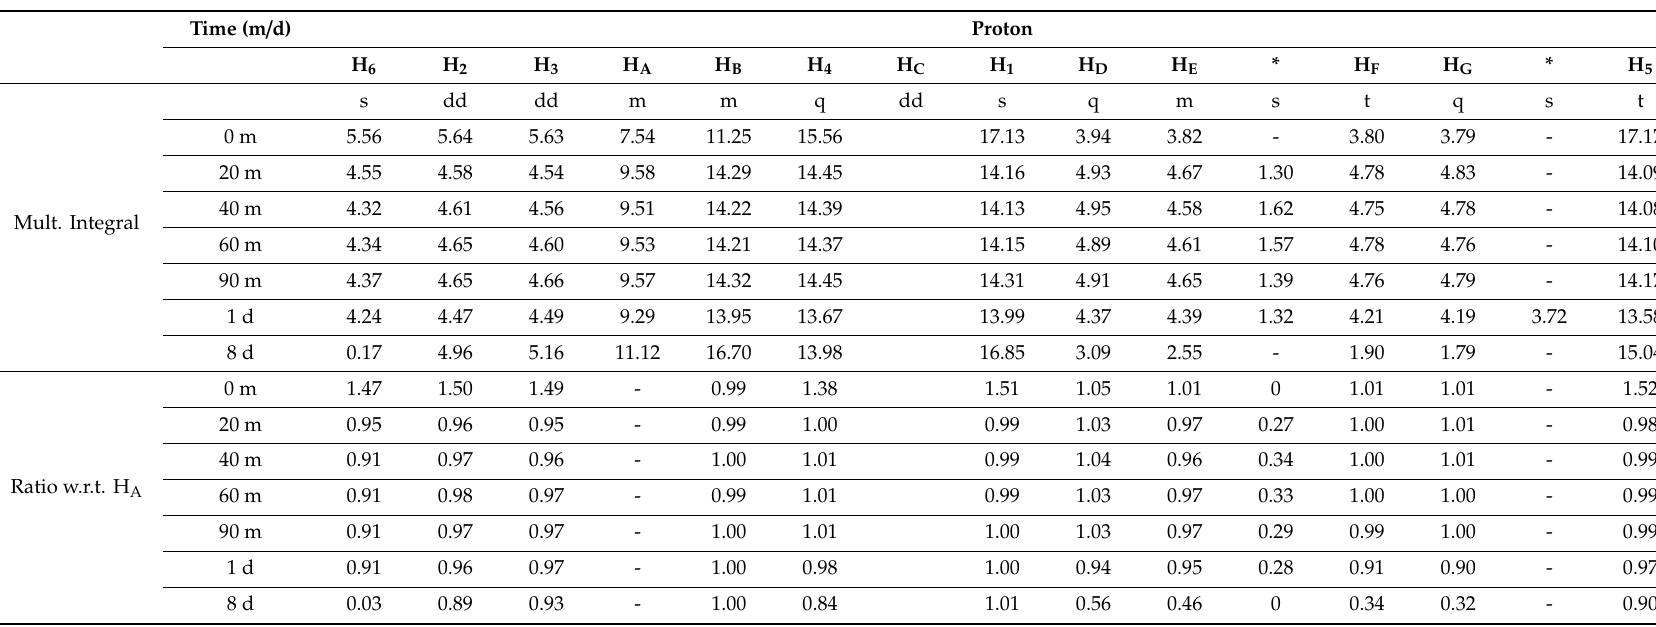
Table 2. 1 H NMR spectral data for equimolar formulation of PGE and 1-ethyl-3-methylimidazolium thiocyanate as a function of storage at room temperature. Time (m / d)